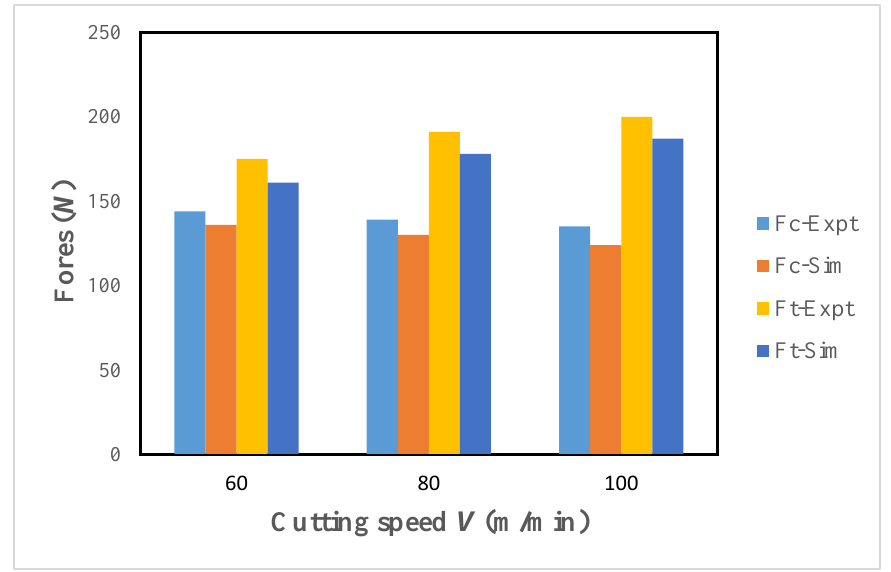
Figure 2. Comparison of the experimental and simulation data for cutting and thrust forces.